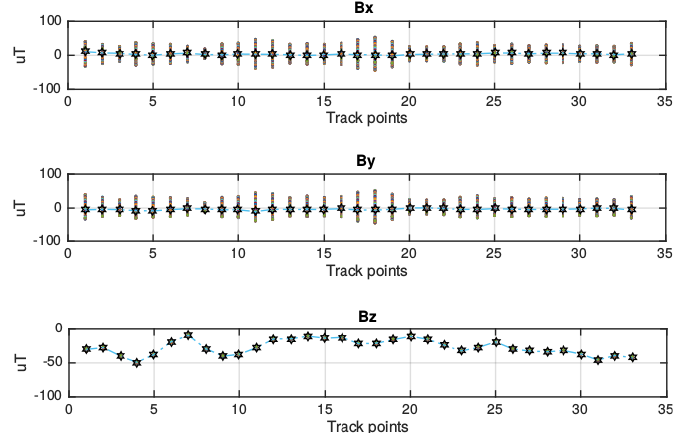
Figure 3. Magnetic field profiles of the